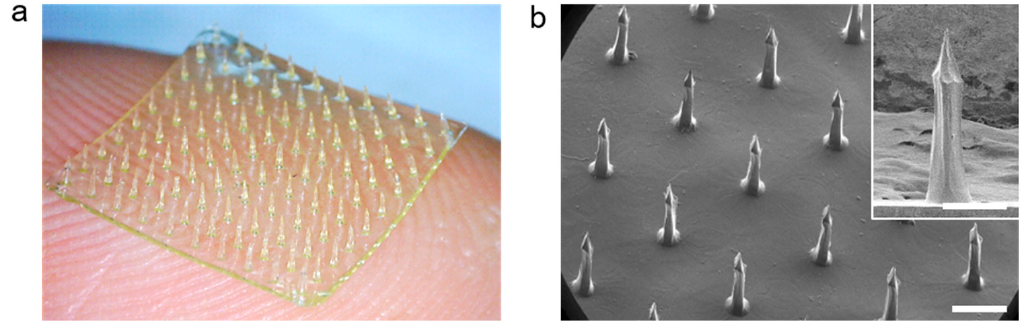
Figure 3. ( a ) A photograph and ( b ) tilted-view SEM images of the bullet-shaped CS MN patch (10 × 10 MNs / cm 2 ), respectively. The CS MN array was reproducibly fabricated with dimensional uniformity (Scale bar; 500 μ m).